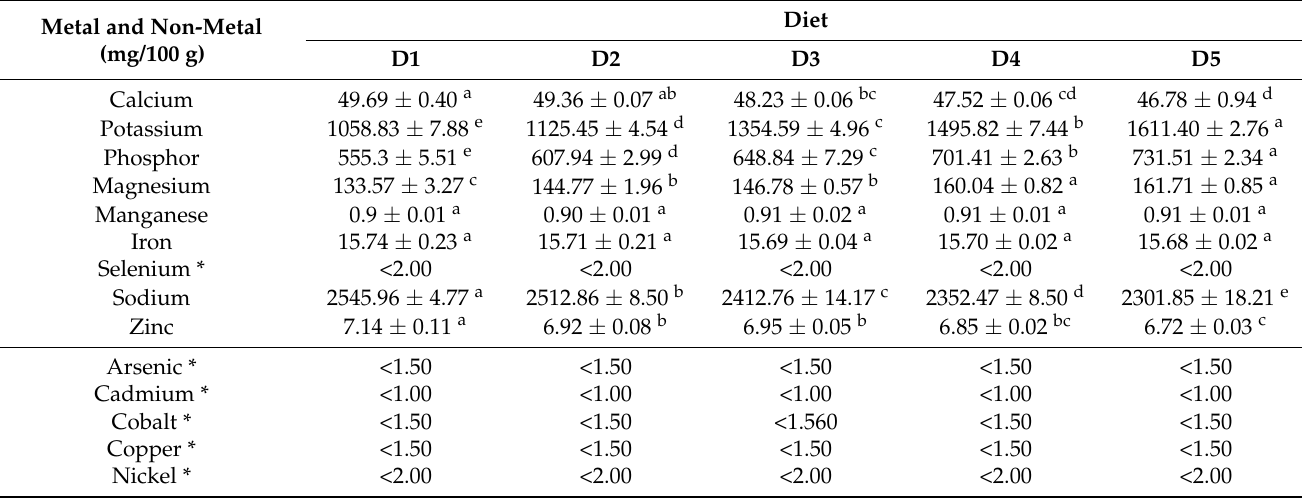
Table 5. Metal and non-metal composition in Zophobas atratus larvae fed a conventional diet with or without grape residue (D1 to D5) for 90 days (dry